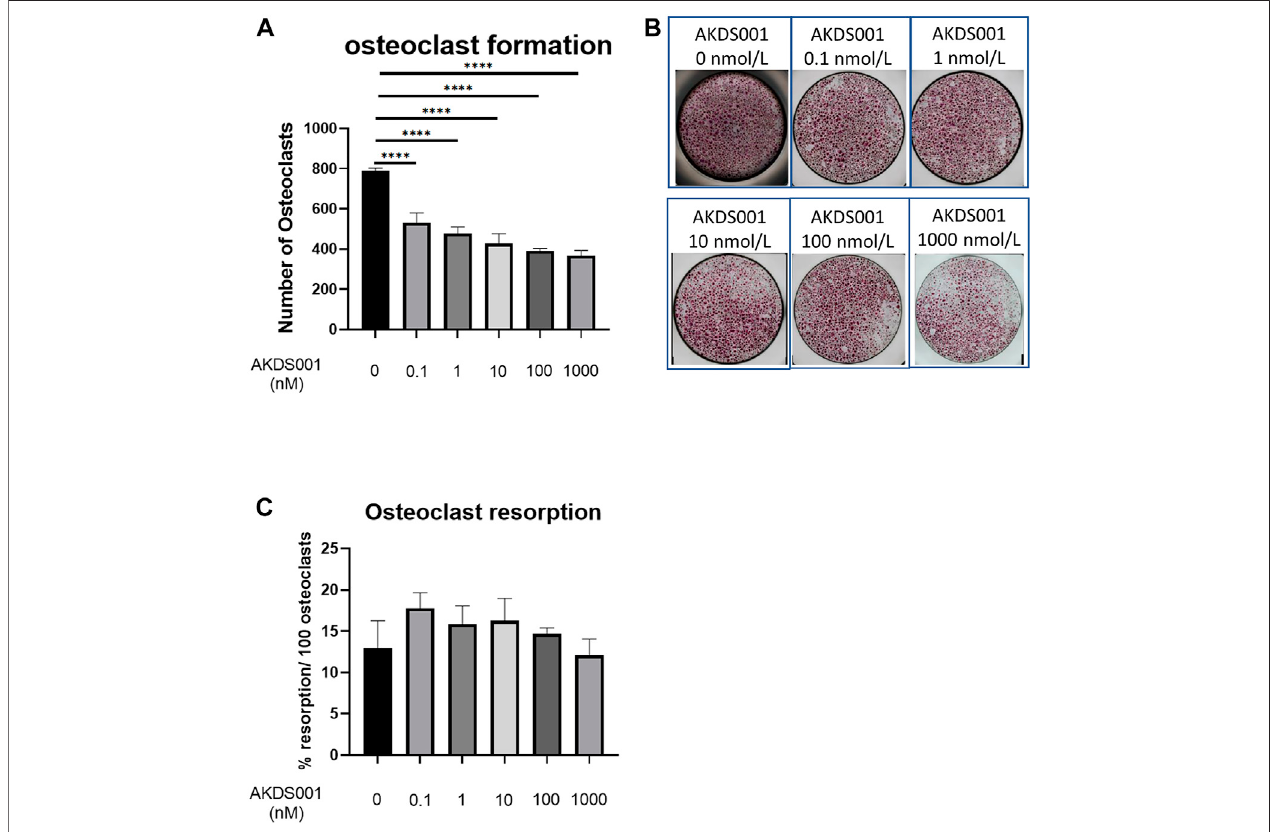
FIGURE 8 | Effect of AKDS001 on human osteoclast precursors. (A) Number of osteoclasts after the induction of osteoclastic differentiation with or without AKDS001 (0.1 – 1000 nM). n = 4 per group. (B) Representative images of osteoclasts after the induction of osteoclastic differentiation with or without AKDS001